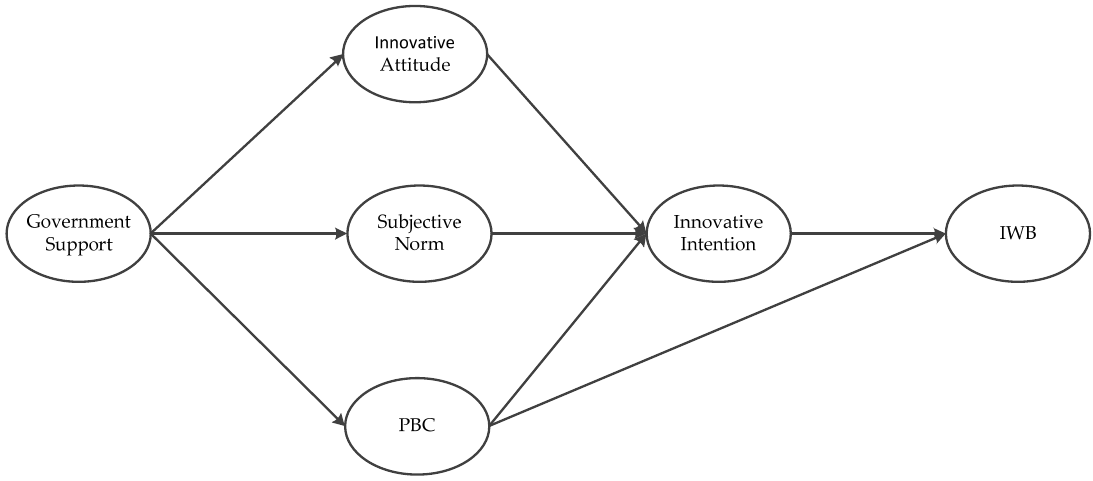
Figure 1. The hypothetical framework.